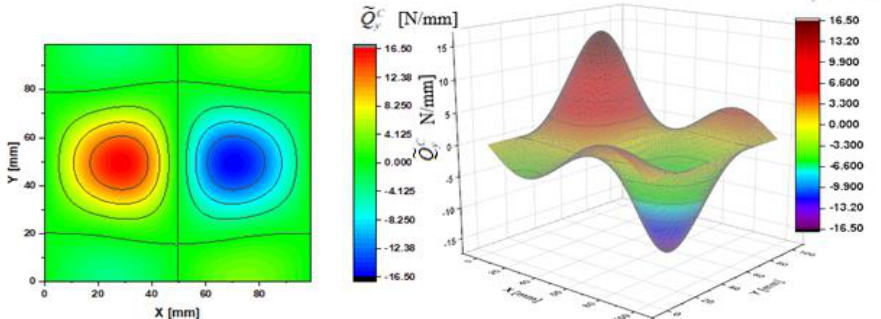
Figure 7. Contour-plane chart of C